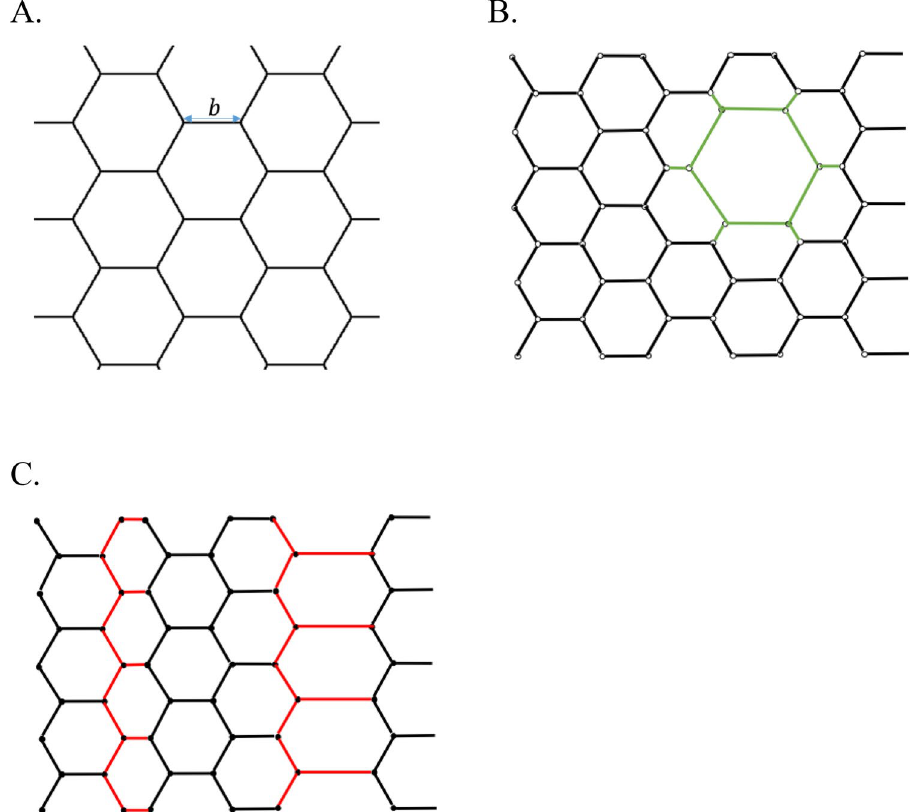
Figure 3. ( A ) A homogenous hexagonal network of hexagon side length denoted by b . ( B ) An example of an energy-preserving isotropic transformation induced by expansion or contraction of an isotropic structural element denoted by the green-colored edges. ( C ) An example for an energy-preserving telescopic transformation induced by expansion/contraction of a linear structural elements denoted by the red-colored